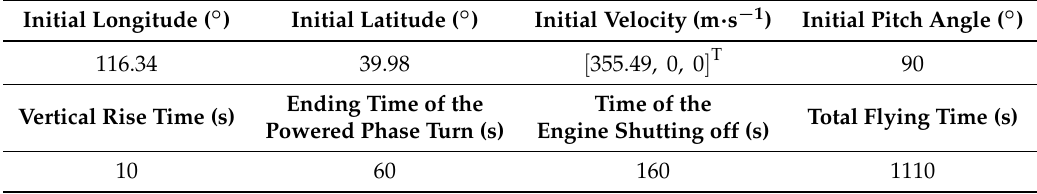
Table 1. Parameters of missile